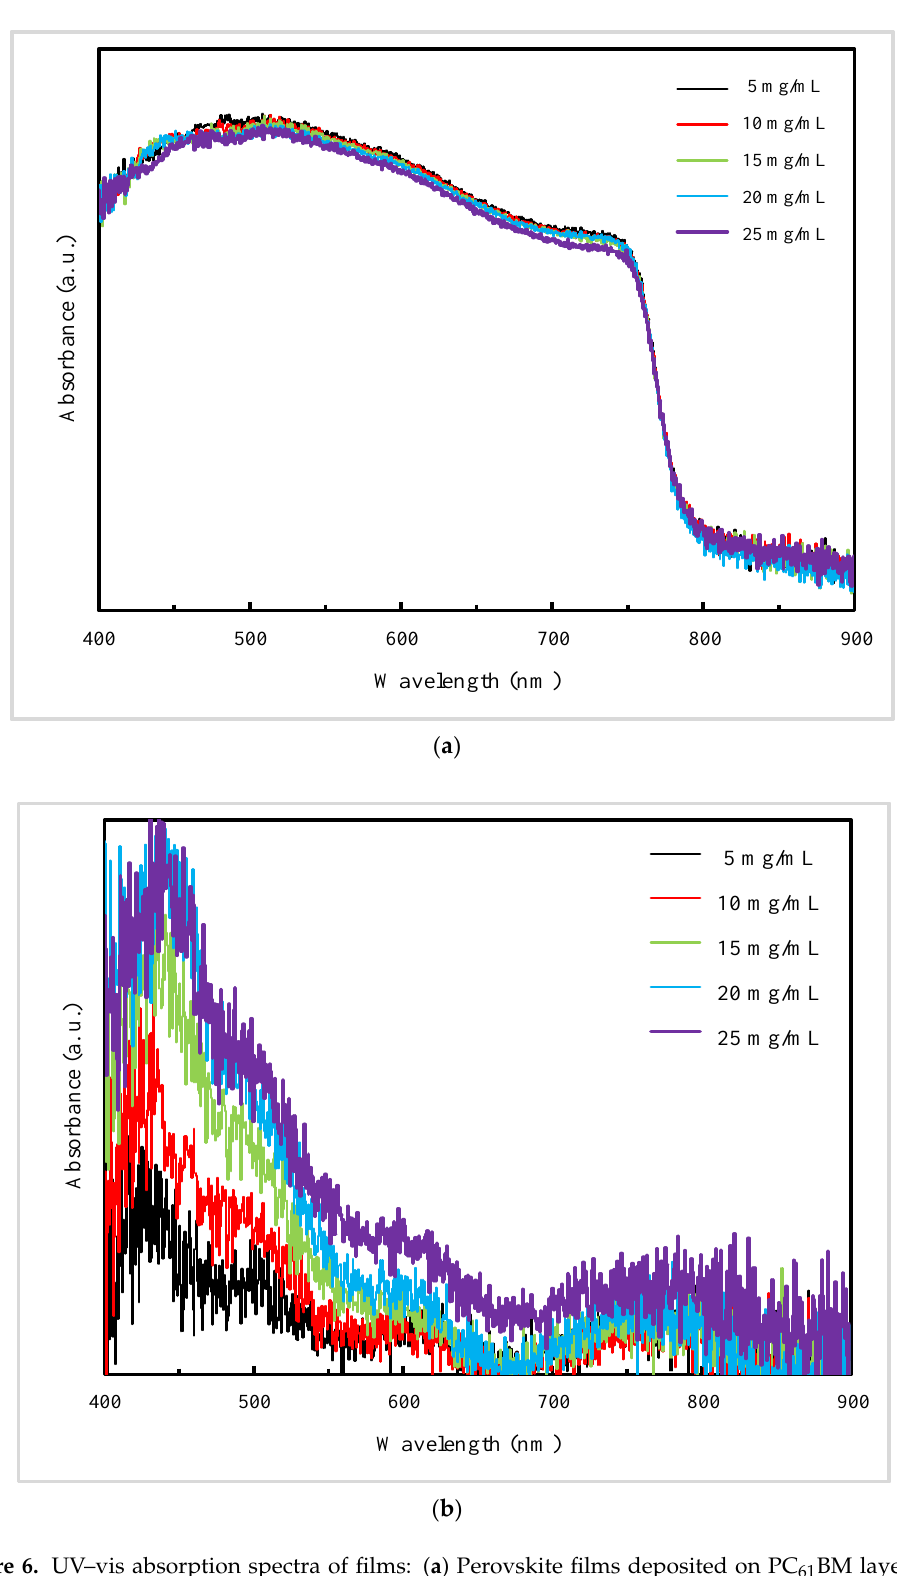
Figure 6. UV–vis absorption spectra of films: ( a ) Perovskite films deposited on PC 61 BM layers of different concentration.; ( b ) PC 61 BM films of different concentration.